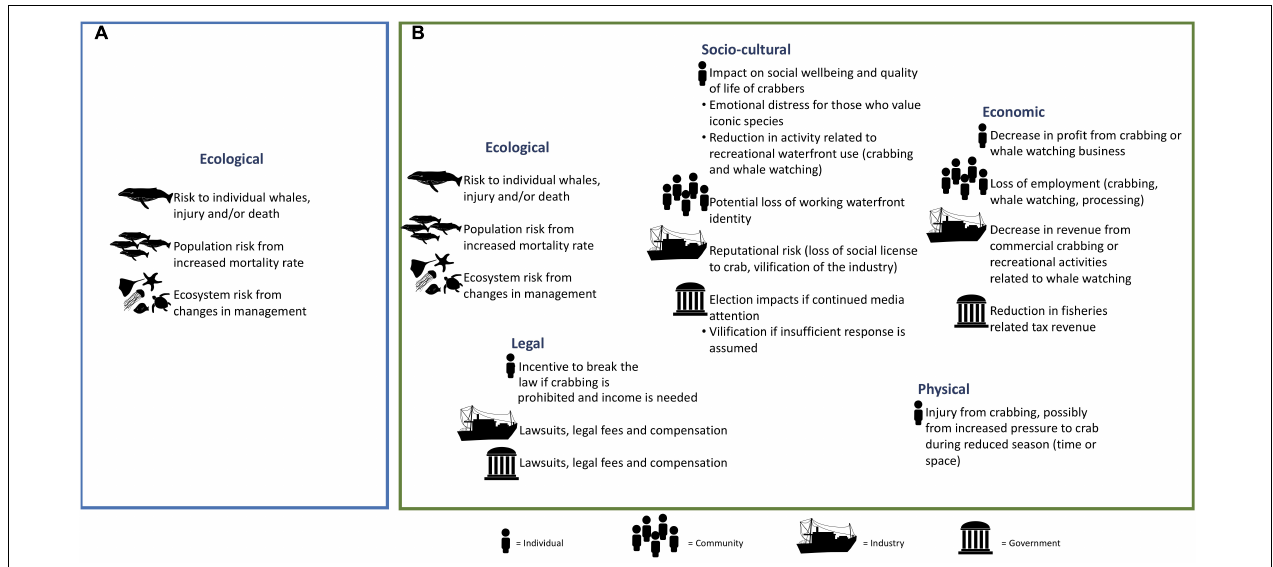
FIGURE 3 | Demonstrating the different elements of the system which may be considered under the current standard of only an ecological focus (A) , as compared to a broader perspective, considering economic, socio-cultural, legal and physical risks (B) . Within the social institutions, we define scales as follows. Individuals are people who may participate in crabbing recreationally or professionally, or individuals who enjoy whale watching, advocate for the protection of whales or are employed by the whale watching industry or conservation organizations. Communities are people that live in and around a community center on the coast, in locations where there are crab and/or whale watching industries, they may include people employed by those industries but those individuals represent only a portion of the larger community. Industries include the crab and whale watching industries. Finally, government includes both elected government bodies and government